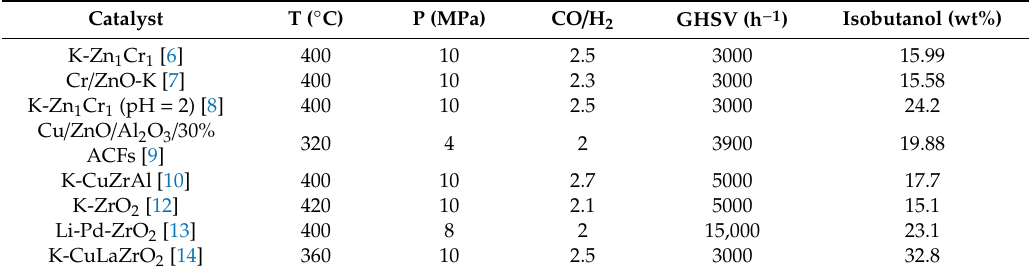
Table 1. Representative isobutanol synthesis